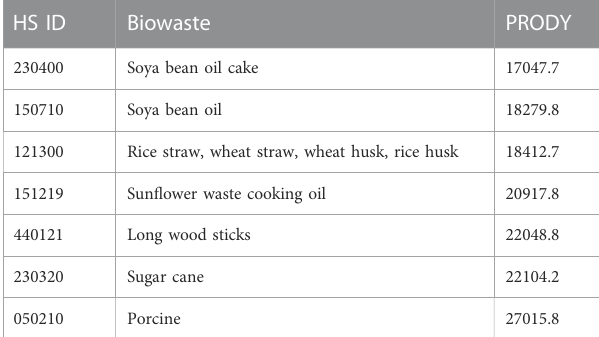
TABLE 2 Medium-Income Potential (MIP).